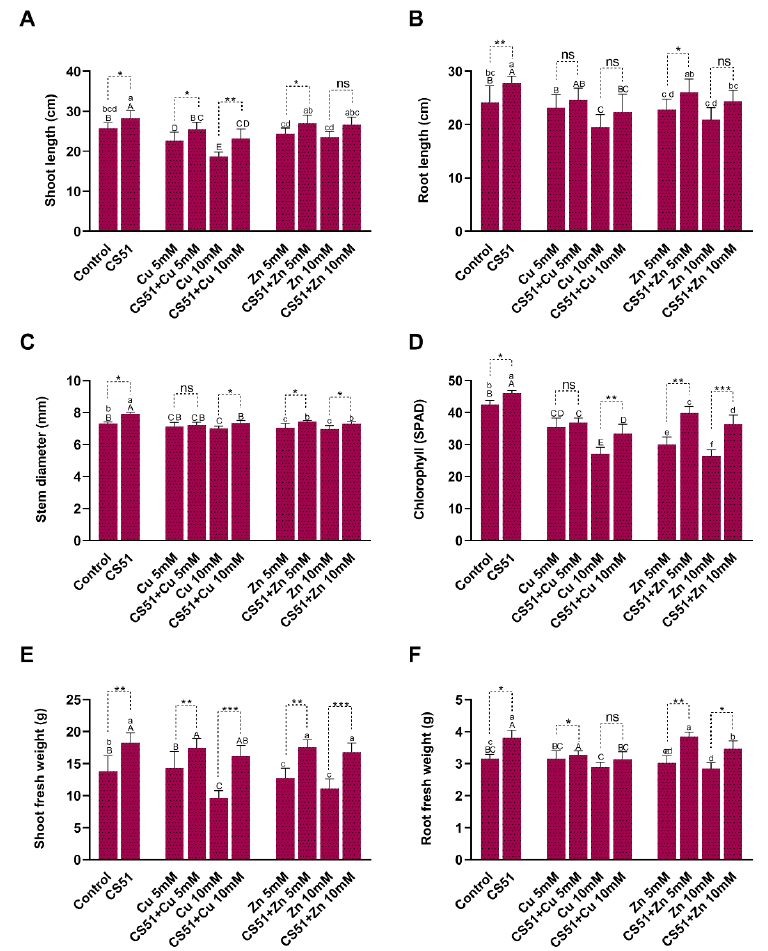
Figure 3. Effect of CS51 on the growth of cucumber plant growth, under control conditions, Cu (5 mM and 10 mM Cu), and Zn (5 mM and 10 mM Zn) stress. Growth parameters include ( A ) shoot length, ( B ) root length, ( C ) stem diameter, ( D ) chlorophyll contents (SPAD), ( E ) shoot fresh weight, and ( F )